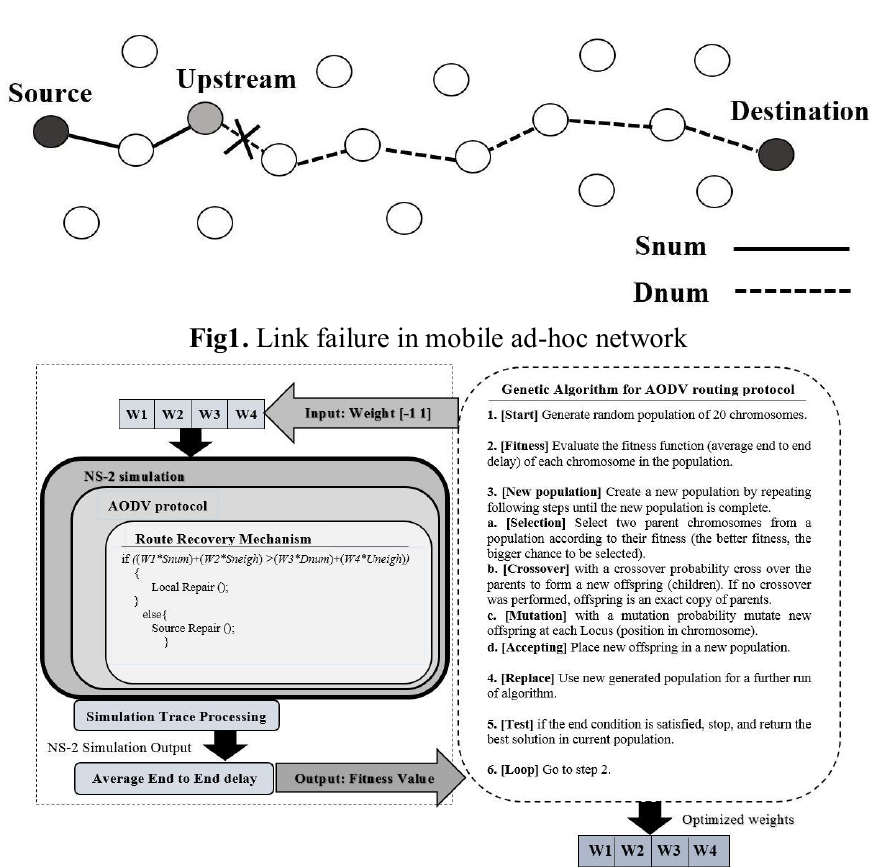
Fig. 2. Optimization strategy for AODV routing protocol in